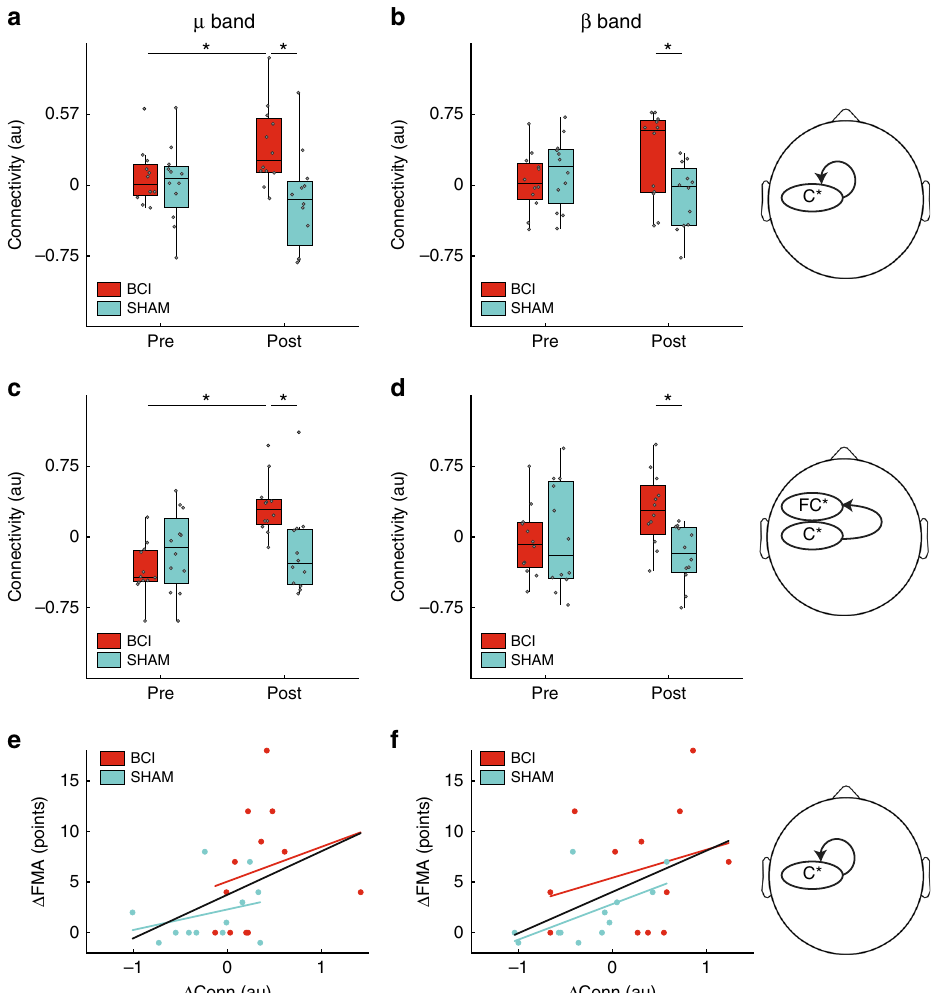
Fig. 2 EEG effective connectivity within affected hemisphere during resting task. A mixed-design ANOVA revealed a signi fi cant increase of EEG effective connectivity after intervention in μ (10 – 12 Hz) (left column) and β (18 – 24 Hz) (right column) frequency bands for the BCI group ( N = 14, red) as compared to the sham group ( N = 13, light blue). Statistical differences are indicated ( * p < 0.05, ** p < 0.001, post-hoc Bonferroni-corrected two-tailed paired/ unpaired t -tests, see text for results on mixed ANOVA). a , b EEG effective connectivity changes within the affected sensorimotor cortex (channels C5*, C3*, and C1*), represented by boxplots (box: 25 – 75% percentiles, whiskers: 5 – 95% percentiles). Single values are also shown, jittered along the x -axis for a better visualization. c , d EEG effective connectivity changes from the affected C* to the FC* line. e , f Change of connectivity (post – pre intervention) within the affected sensorimotor cortex vs FMA post – pre intervention, together with the least-squares fi t line for both groups pooled ( N = 24, black line). Signi fi cant correlations were found in both μ and β frequency bands (Pearson ’ s correlation, μ : r = 0.41, p = 0.045; β : r = 0.48, p = 0.02). Least-square fi ts for each group separately are also shown for representation purposes (colored lines; N = 12 for BCI and sham